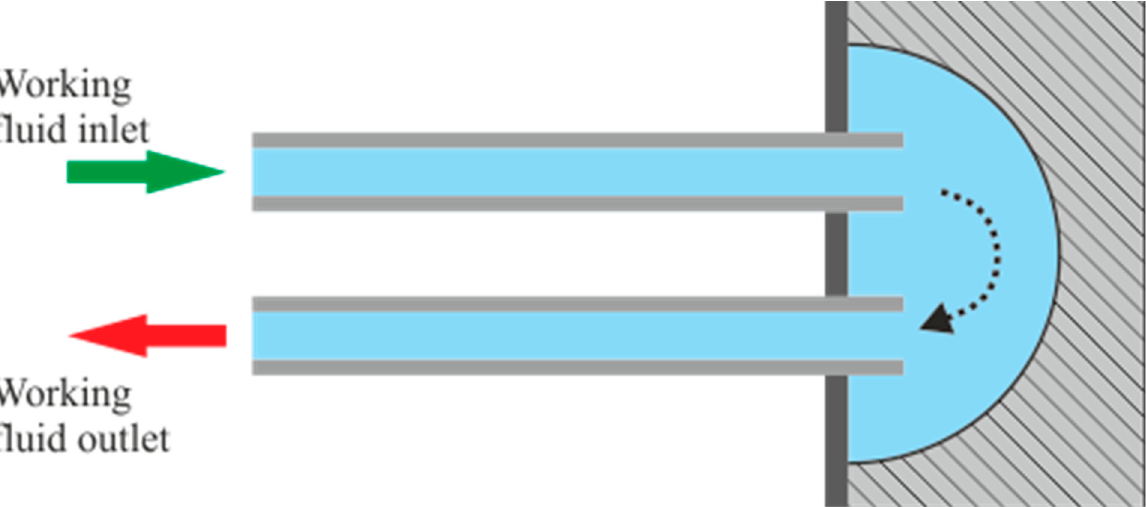
Figure 2. Schematic representation of a mixing chamber linking one row of tubes to the following one. The arrows represent the direction of the WF flow, colored in blue.